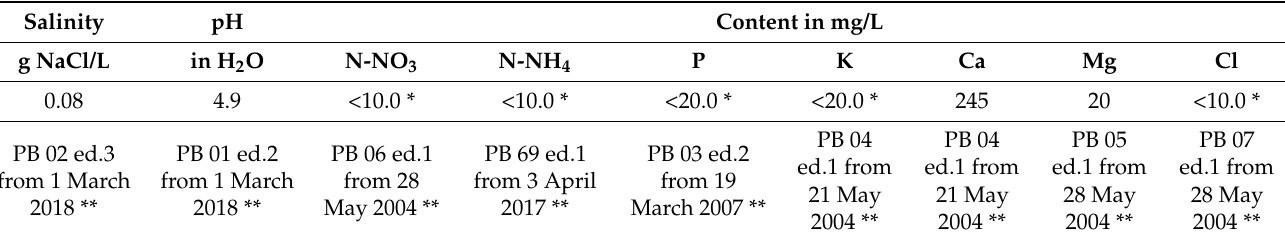
Table 2. Soil testing report no. GO/502/18.